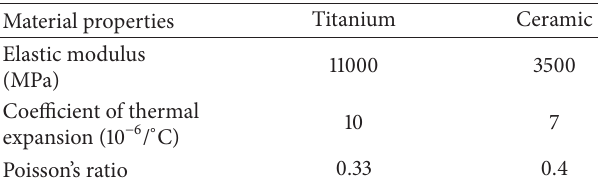
Table 3: Material properties used in the